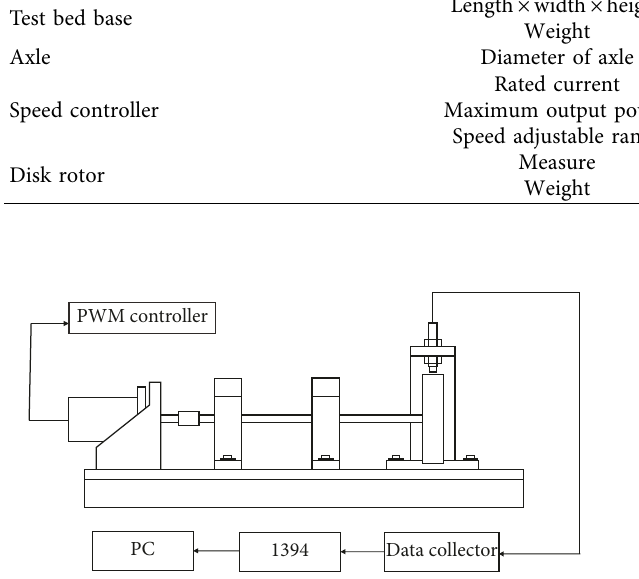
Figure 14: Four phase angles define corresponding